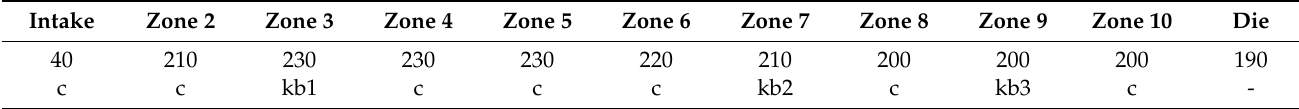
Table 2. Temperature profile (top lines, all values given in ◦ C) and screw geometry (bottom line, each zone represents approx. 4 L/D, except the die) of the co-rotating twin-screw extruder. The screw geometry is given as: c—conveying elements (feed screws, each 1 L/D long), kb1—kneading block 1 (consisting of 5 × 30 ◦ , 7 × 60 ◦ , 4 × 90 ◦ kneading blocks) for polymer melting, kb2—kneading block 2 (consisting of 7 × 60 ◦ , 6 × 90 ◦ ) for fiber mixing, and kb3—kneading block 2 (consisting of 4 × 60 ◦ , 4 × 90 ◦ ) for fiber mixing. Each kneading block element represents 1 / 4